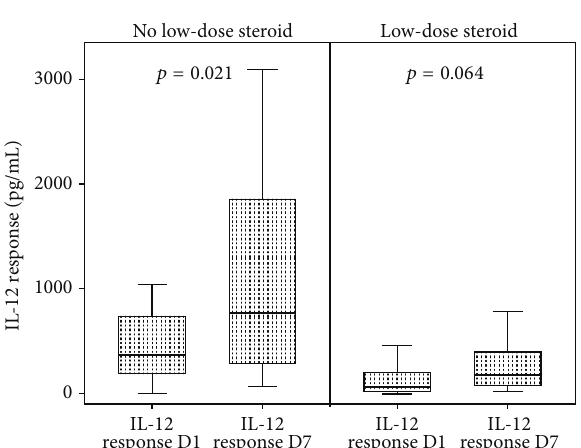
Figure 1: Interleukin- (IL-) 12 responses significantly recover in no low-dosesteroidgroup.TheboxplotsshowmedianofIL-12response in day 1 and day 7 in groups with and without low-dose steroid